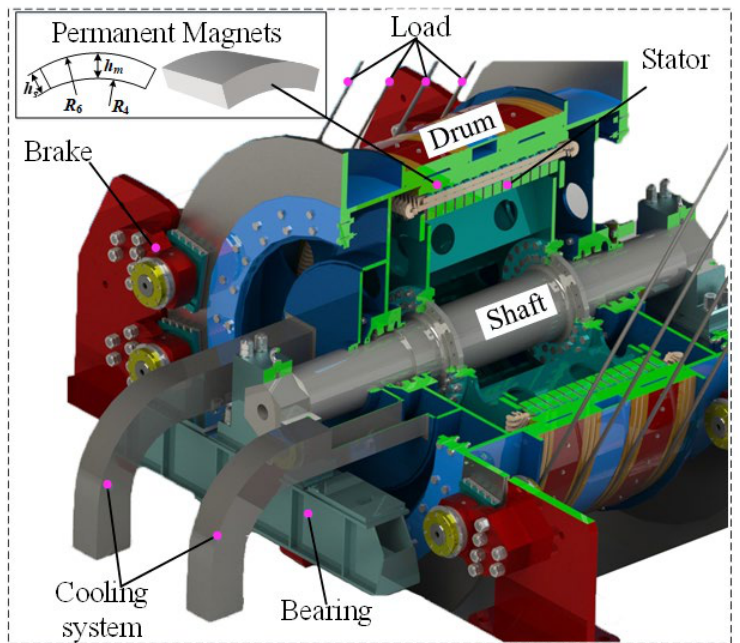
Figure 1. Three-dimensional structure of the LHPMSM.